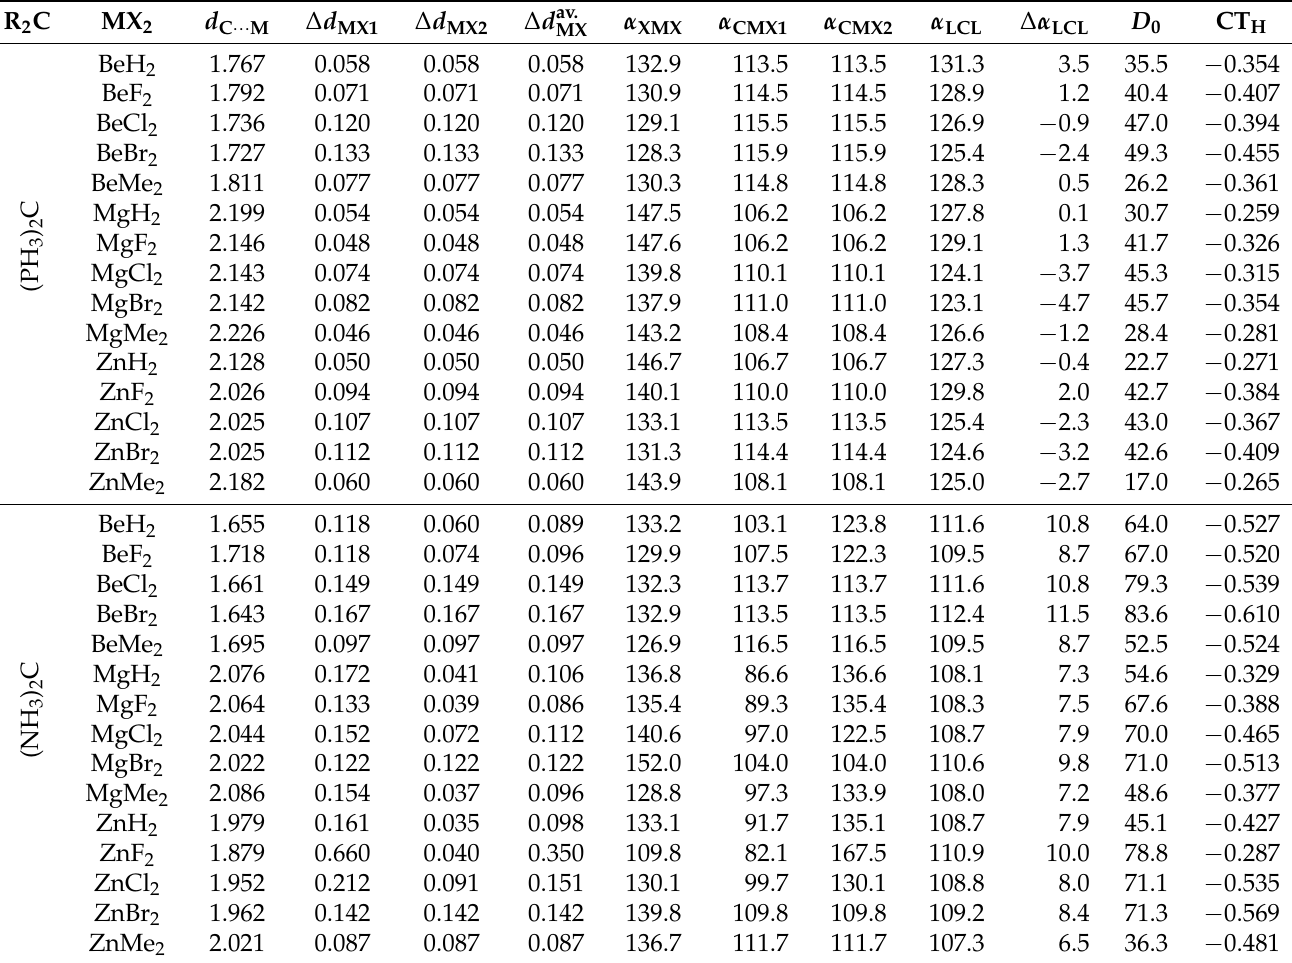
Table 4. Some fundamental data characterizing CDP · · · MX 2 dimers: C · · · M distance (in Å), changes of MX1 and MX2 bond lengths (in Å), XMX, CMX1, CMX2, LCL angles (in degrees), dissociation energy (in kcal/mol), charge transfer (in